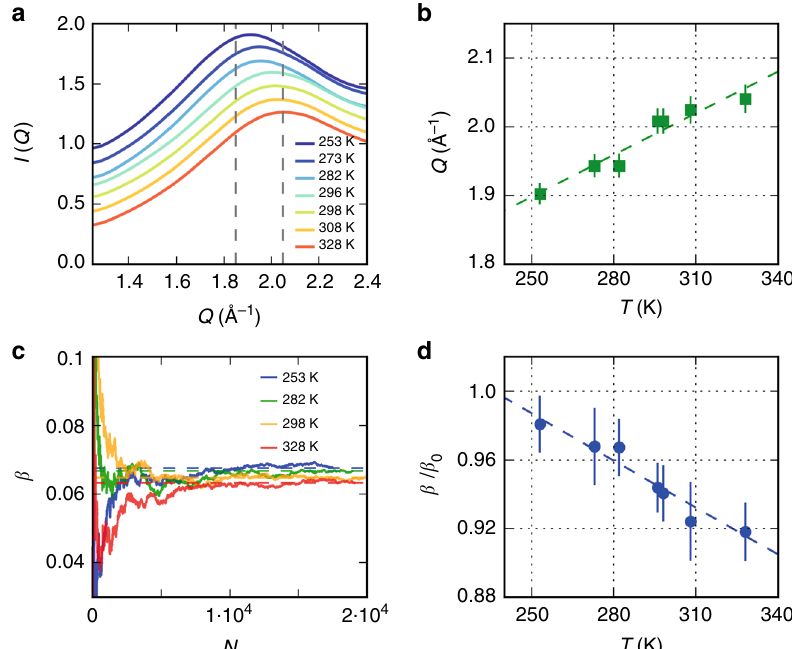
Fig. 4 Temperature dependence. a Temperature dependence of the angularly integrated scattering intensity I ( Q ) as a function of momentum transfer Q . The dashed lines indicate the Q -range over which the speckle contrast was investigated. b Q value of the maximum of I(Q) , where the dashed line highlights the shift of the peak to lower Q upon cooling. The errorbars is the standard error. c Cumulative average of the speckle contrast β over number of X-ray laser shots N for different temperatures as indicated in the fi gure. The dashed lines indicate the total average. d Corresponding average values of β / β 0 , with error bars corresponding to the standard error. The dashed line highlights the increase of the speckle contrast upon cooling, which is an indication of gradual slowing down of the molecular motion within the exposure time δ t = 75